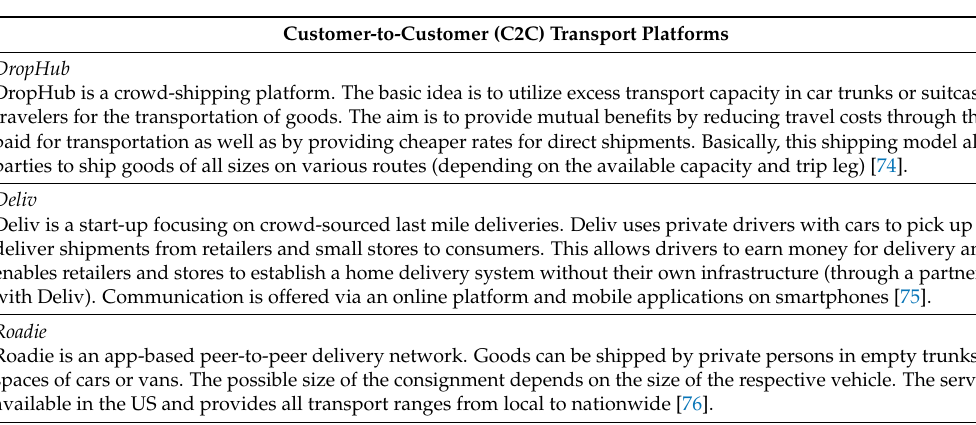
Table 7. Practical examples of customer-to-customer transport